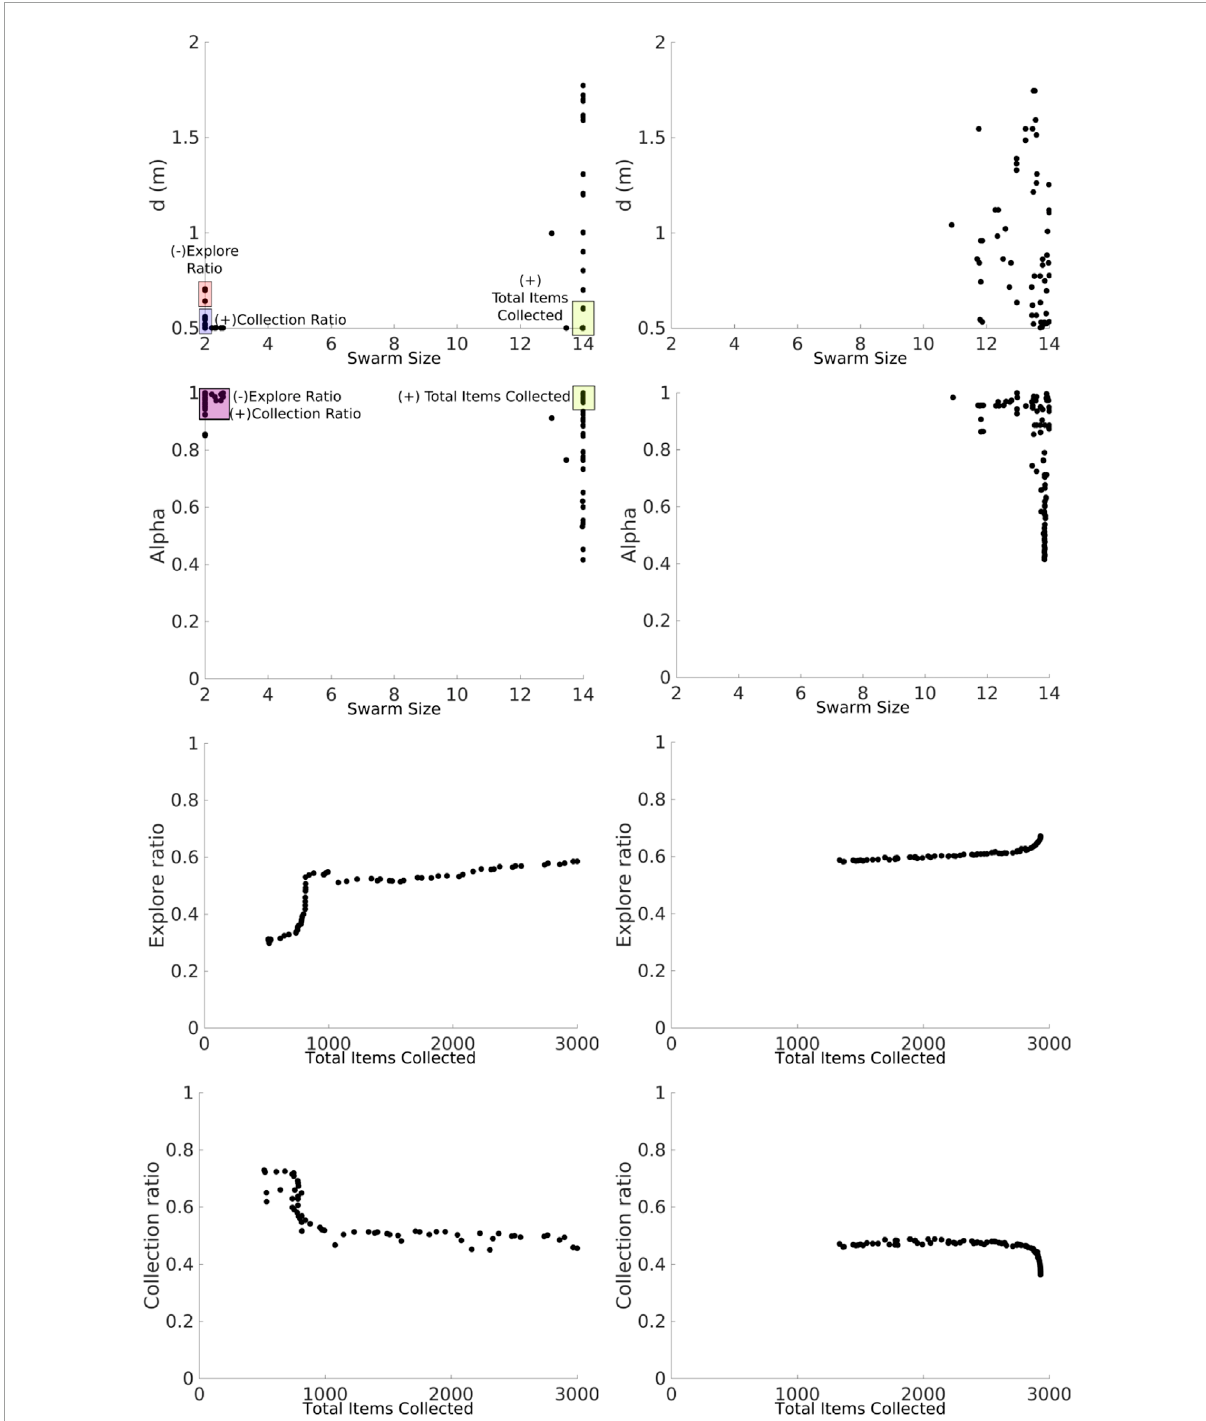
FIGURE 11 NSGA-II results for the DPS with heterogeneous (left column) and homogeneous (right column) errors. Two-dimensional inputs are shown as swarm size—d (first row) and swarm size—alpha (second row). Two-dimensional outputs are shown as total items collected—explore ratio (third row) and total items collected—collection ratio (fourth